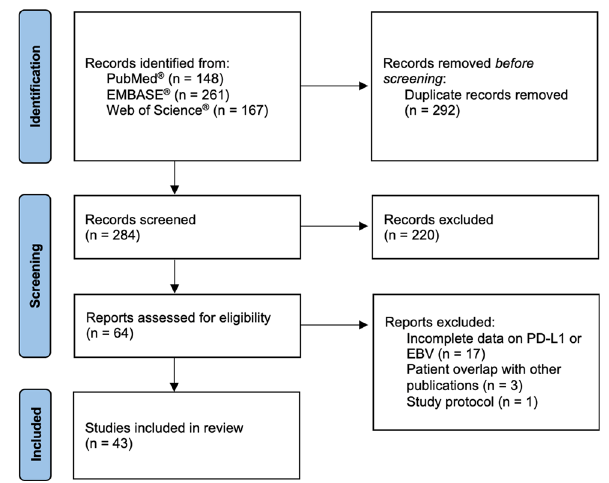
Fig. 1 PRISMA flow chart for systematic review and meta-